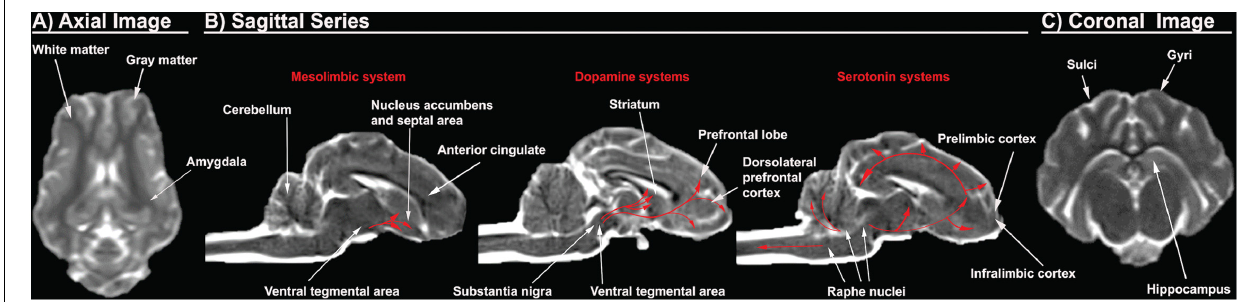
FIGURE 2 | Porcine T2Weighted MRI sequences display critical cerebral structures involved with AUD. An axial slice of the porcine brain displays high white matter composition more comparable to humans than rodents (A) . Sagittal sequences display the dorsolateral prefrontal cortex, which is present in pigs and humans, but absent in rodents, as well as anterior cingulate, prelimbic cortex, and infralimbic cortex. The distribution of the dopamine and serotonin systems are traced in red arrows (B) . A coronal slice shows gyri and sulci, which are present in pigs and humans, but absent in rodents. The pig and human hippocampus are comparable in terms of structure and orientation (C)